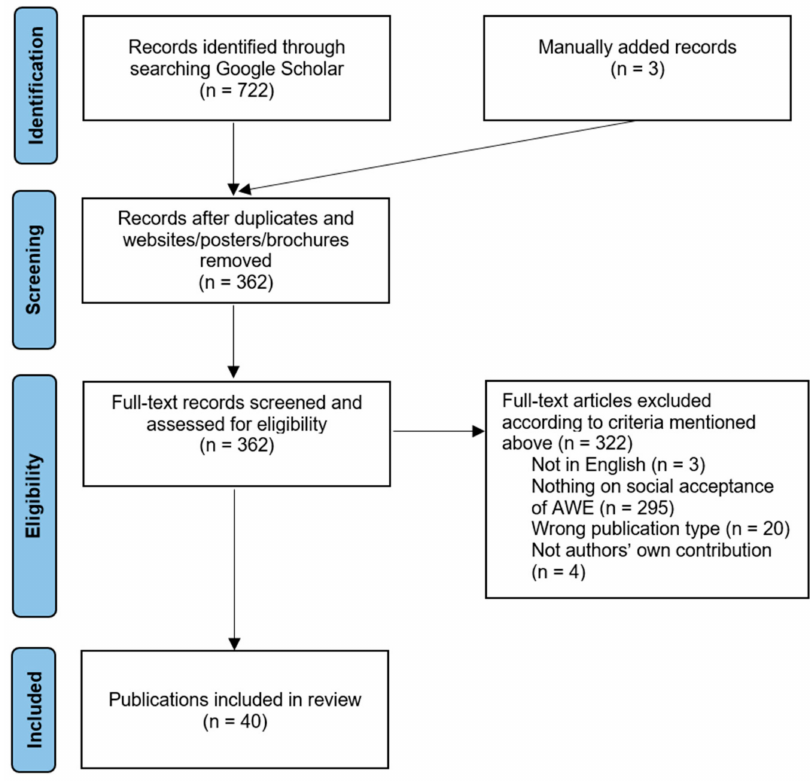
Figure 4. Flow diagram of the selection process for publications on the social acceptance of airborne wind